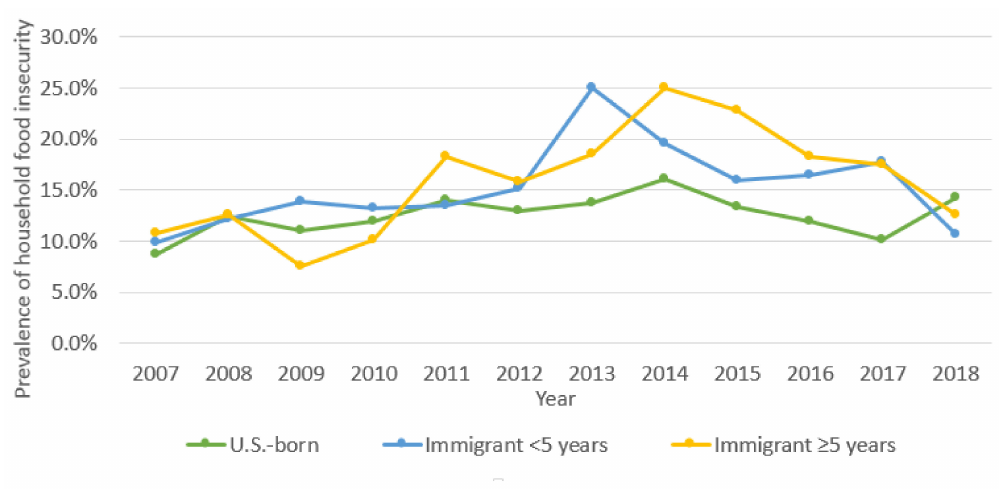
Figure 2. Trends in household food insecurity 2007–2018 by mother’s place of birth.